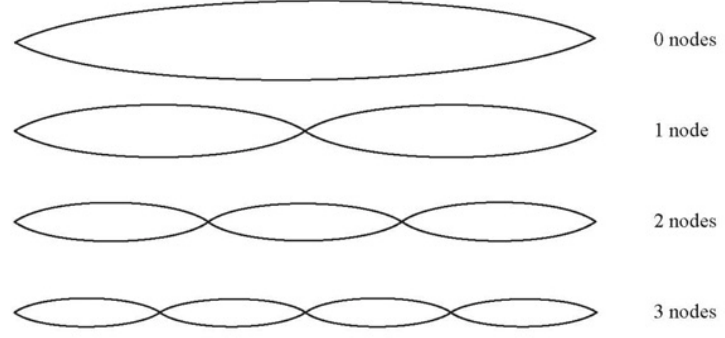
FIGURE 1 . A swinging string’s node points. This system is developed so the swings correspond to 1, 2, 3, etc. nodes. Each node has its own swing speed, corresponding to its frequencies, equivalent to the original string’s frequency multiplied by the amount of nodes. By this, a number of tones, called the number of overtones, are formed (see also